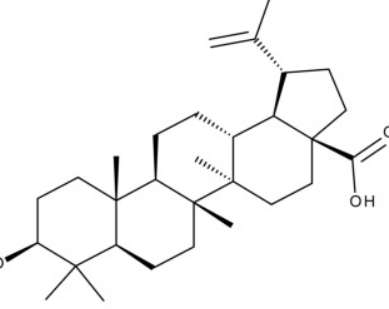
Figure 16. Chemical structure of betulinic acid.